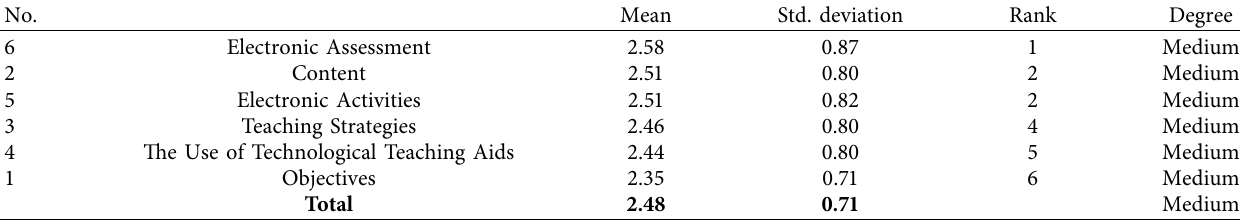
Table 1: Standard deviations, means, ranks, and degree of the study sample on the scale of the degree of appropriateness of English e- curriculum from the point of view.